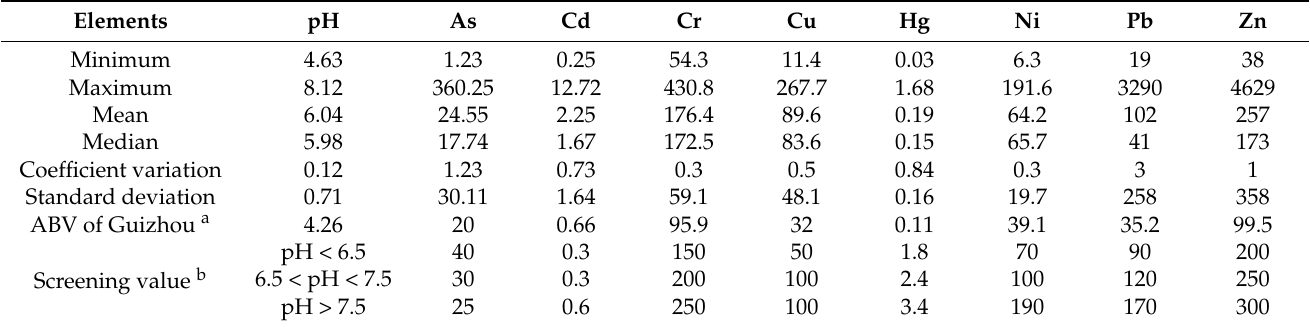
Table 1. Summary statistics of trace metal concentrations in topsoil samples.